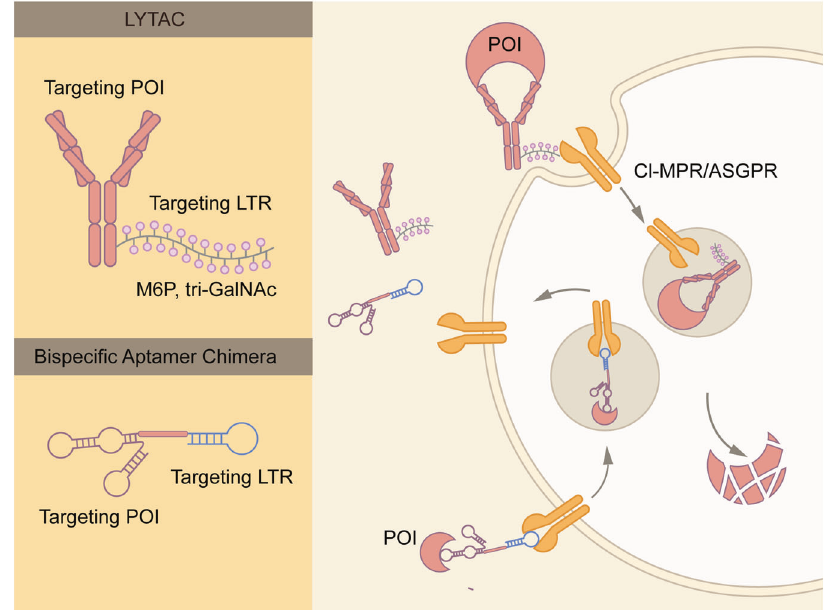
Fig. 7 Schematic representation of LYTAC and Bispeci fi c Aptamer Chimera. LYTAC is composed of a small molecule or an antibody conjugated to a ligand that binds to lysosome-targeting receptors (LTRs), such as CI-MPR and ASGPR. Whereas CI-MPR is ubiquitously expressed in all human tissues, ASGPR is only expressed in liver. Thus, ASGPR-base LYTAC could achieve liver speci fi c protein degradation. CI-MPR or ASGPR is endocytosed along with LYTAC molecules and the POI. Whereas the POI is degraded by lysosomes, CI-MPR, or ASGPR is recycled to the plasma